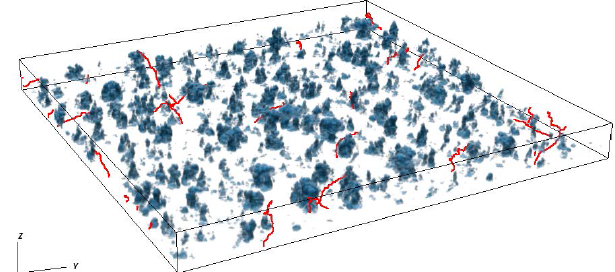
Figure 1. Time snapshot of the BOMEX shallow cumulus cloud field. Displayed are q c and selected parcel trajectories (red).